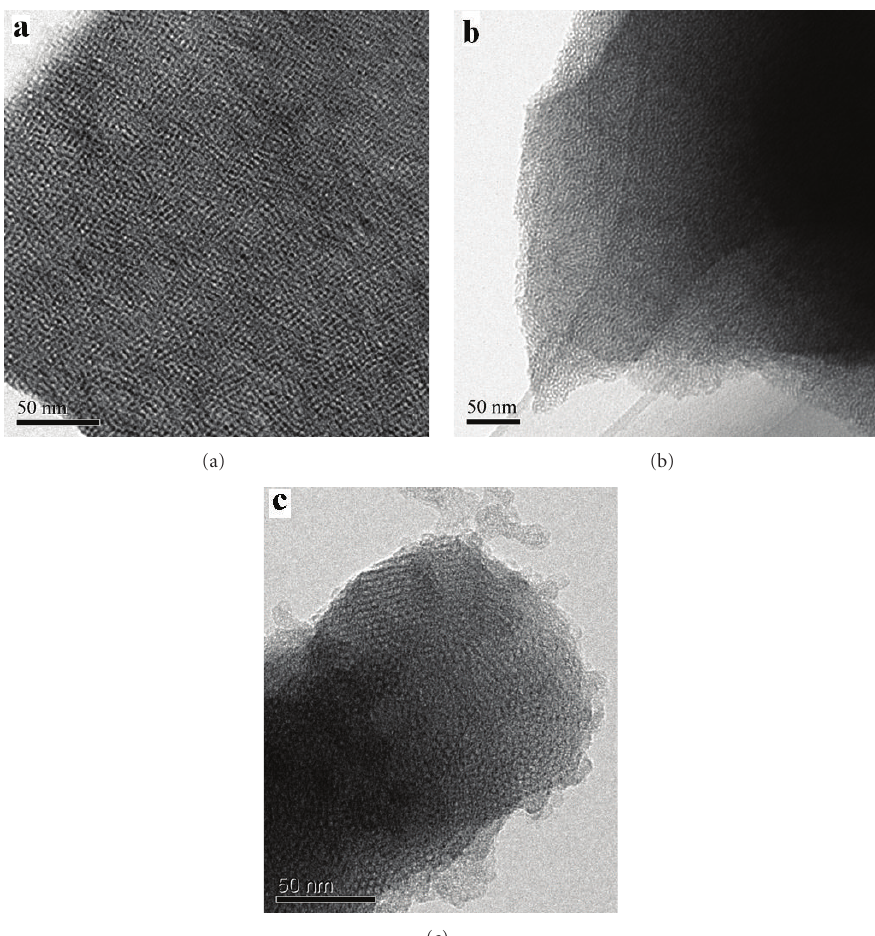
Figure 5: HRTEM images of (a) MCM-41, (b) TiO 2 /MCM-41, and (c) ZTM7 sample.